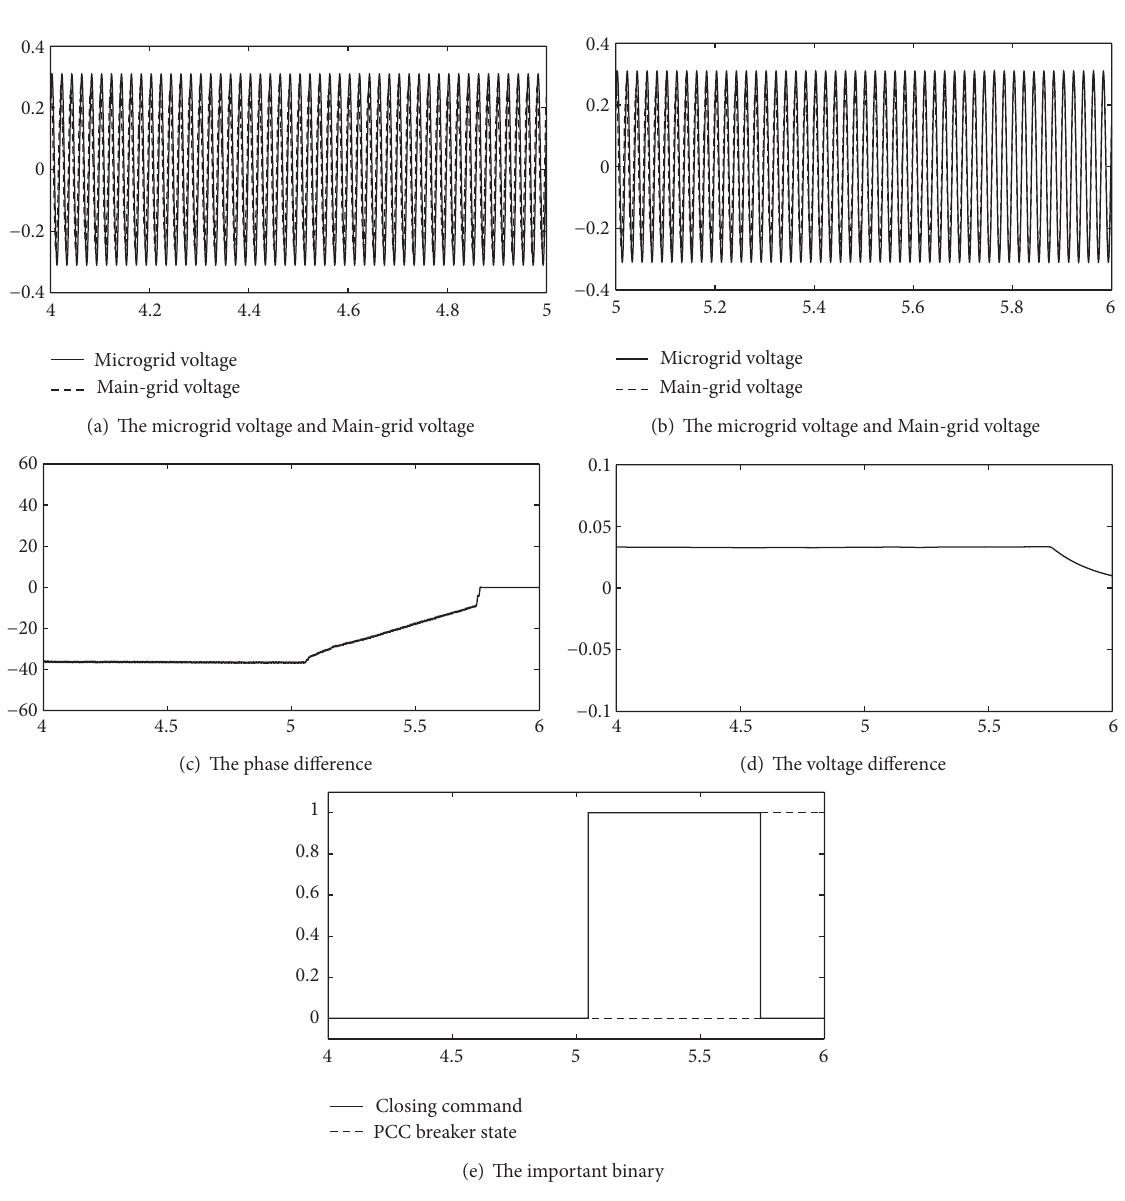
Figure 8: Operation results